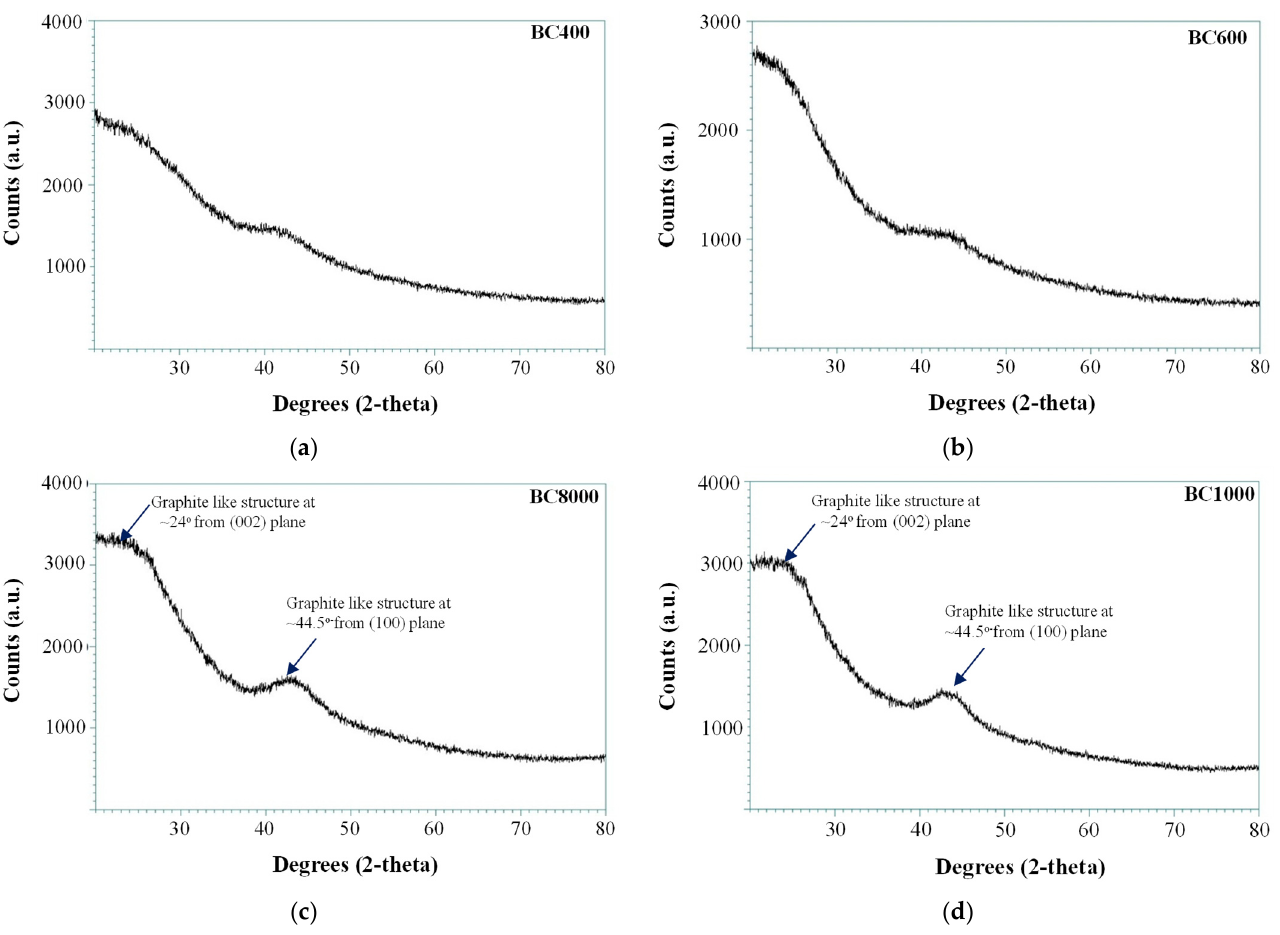
Figure 4. X-ray diffraction pattern of SB biochar produced at pyrolyzing temperatures ( a ) 400 °C ( b ) 600 °C ( c ) 800 °C and ( d ) 1000 °C.